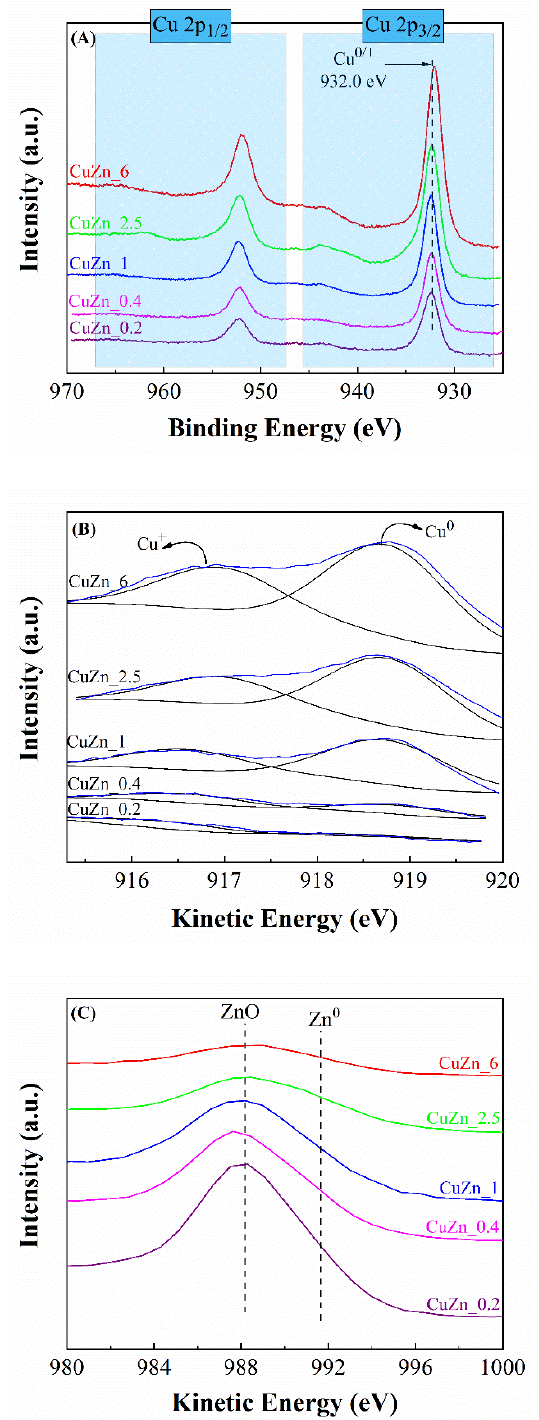
Figure 8. Cu 2p core level ( A ), Auger Cu LMM ( B ) and Auger Zn LMM ( C ) spectra of CuZn_X catalysts.